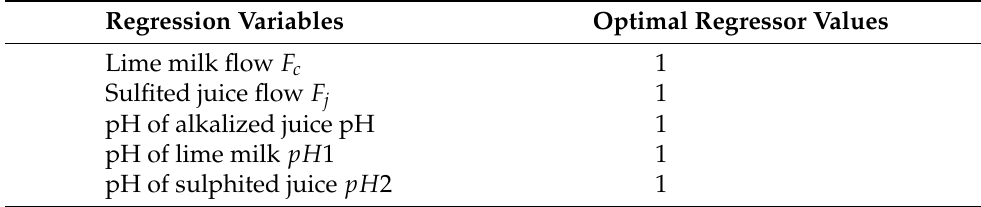
Table 5. Tuning values for the SIB T-S and CBMD .